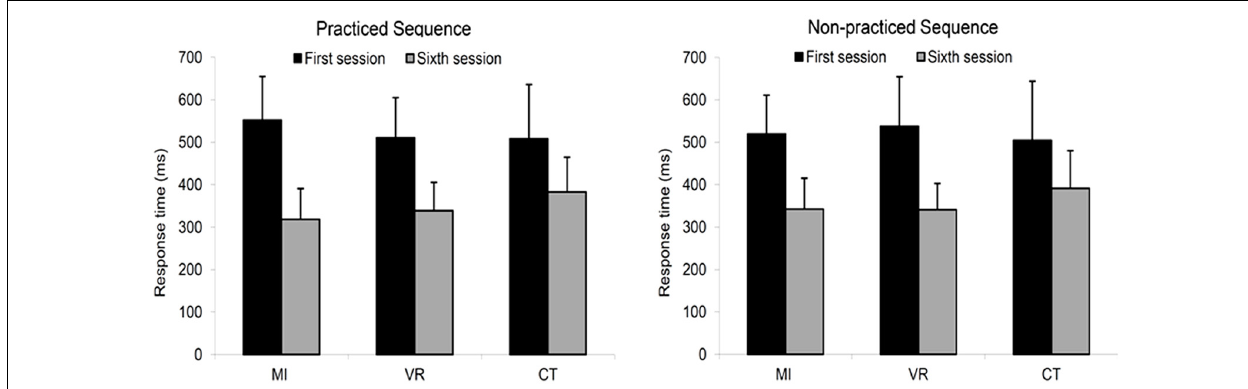
FIGURE 2 | Mean ( + SD) responses times for the practiced and non-practiced sequence, in each group, at sessions 1 and 6. MI, Motor imagery group; VR, verbal rehearsal group; CT, control group.